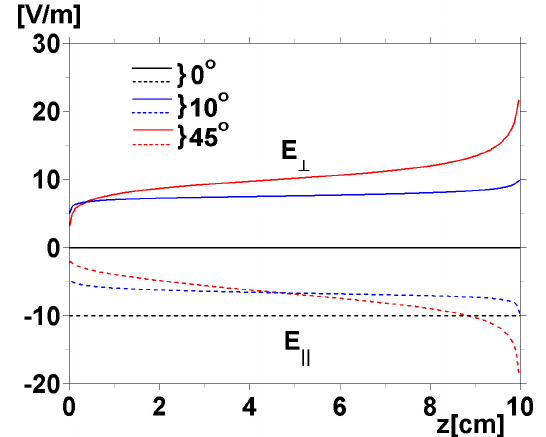
FIG. 2. (Color) E k (dashed) and E ? (full) along a line 100 (cid:2) m away from the insulator surface in vacuum for the system in Fig. 1 with an anode-cathode separation of 10 cm, 1 V applied (cid:5) 3 for three cone voltage, and " r